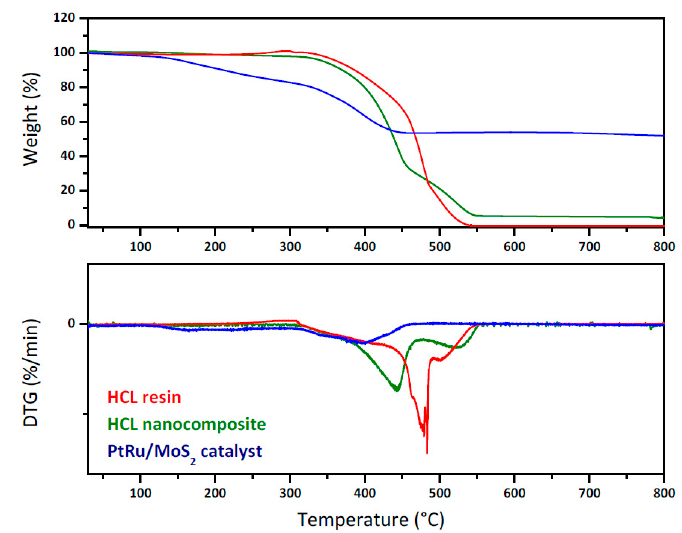
Figure 6. TG-DTGA analysis of PtRu/MoS 2 nanoparticles, HCL resin, and HCL nanocomposite.